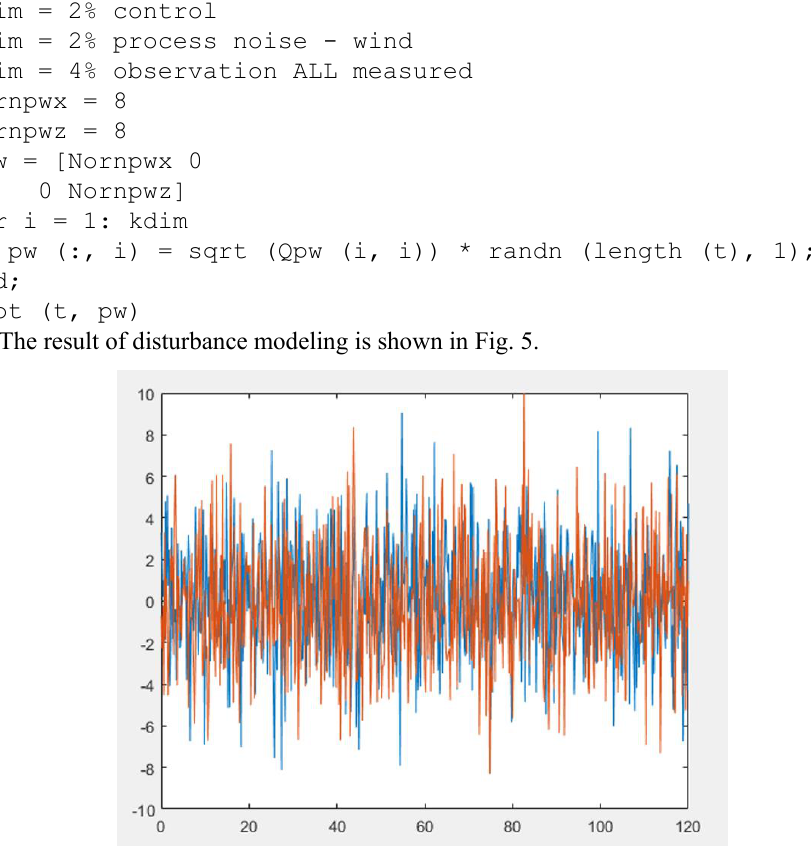
Fig. 5. The result of modeling wind load